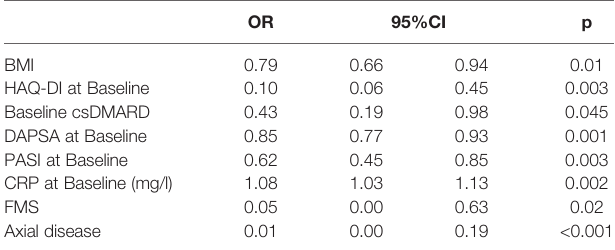
TABLE 2 | Odds Ratios of Logistic Regression for Multivariable Analysis after Random Feature Elimination. OR 95%CI p BMI 0.79